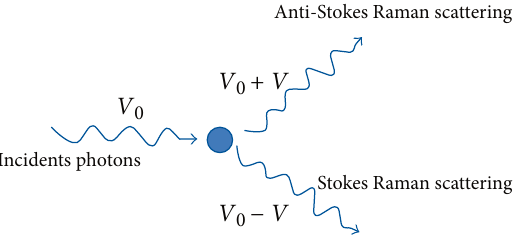
Figure 1: Schematic of inelastic collision showing anti-Stokes Raman scattering and Stokes Raman